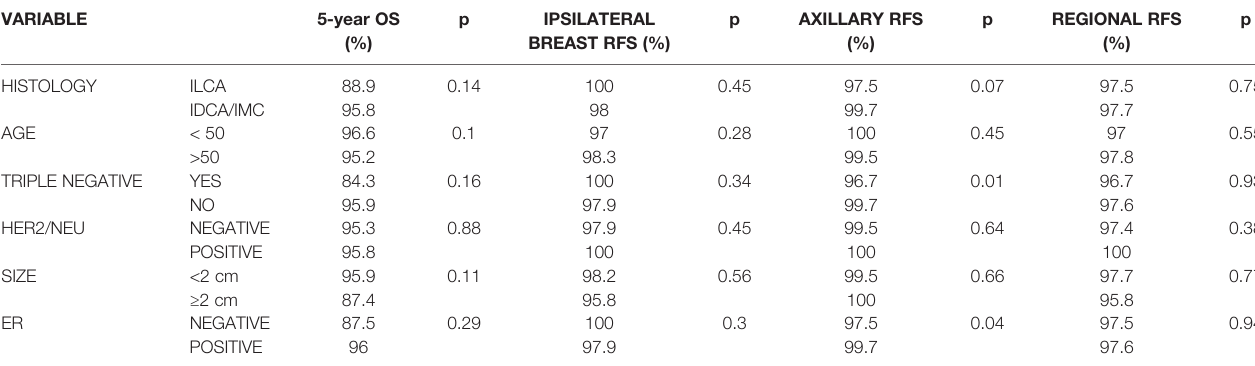
TABLE 2 | Actuarial 5-year overall survival, ipsilateral breast recurrence-free survival (RFS), axillary RFS, and regional (breast and axillary) RFS. VARIABLE